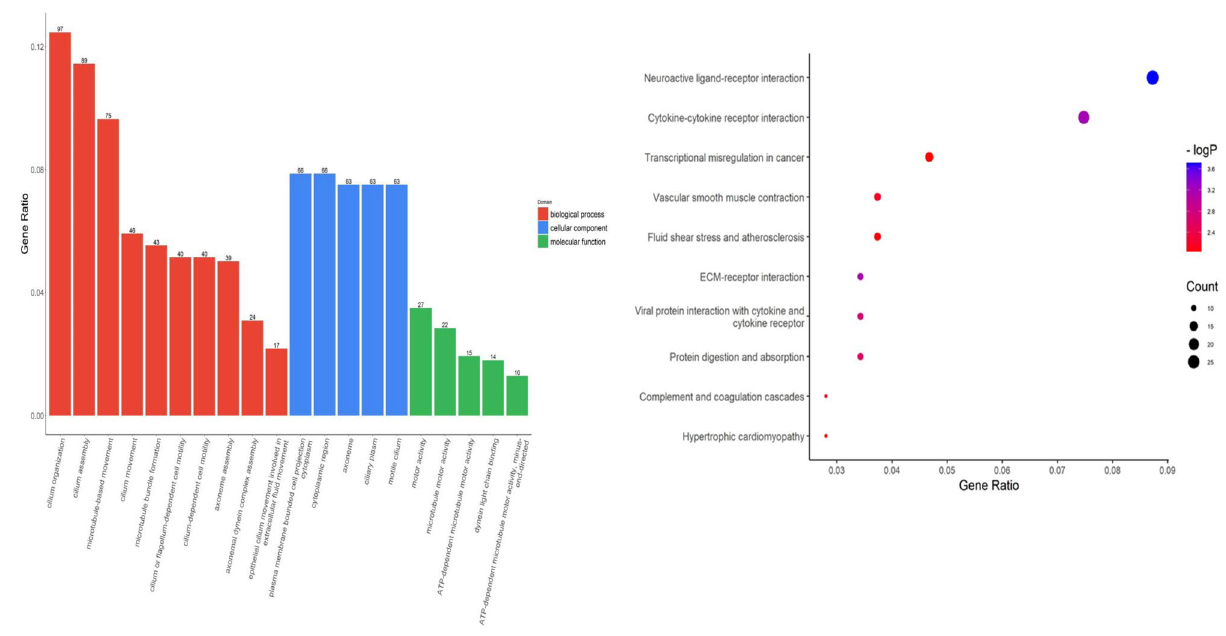
Figure 3. GO and KEGG analyse of DEGS. Left: GO functional analysis for DEGs were grouped into different functional categories: biological process (BF), cellular component (CC) and molecular function (MF). Right: Representative dot plot of top 10 significantly ( P < 0.05) enriched KEGG pathways for